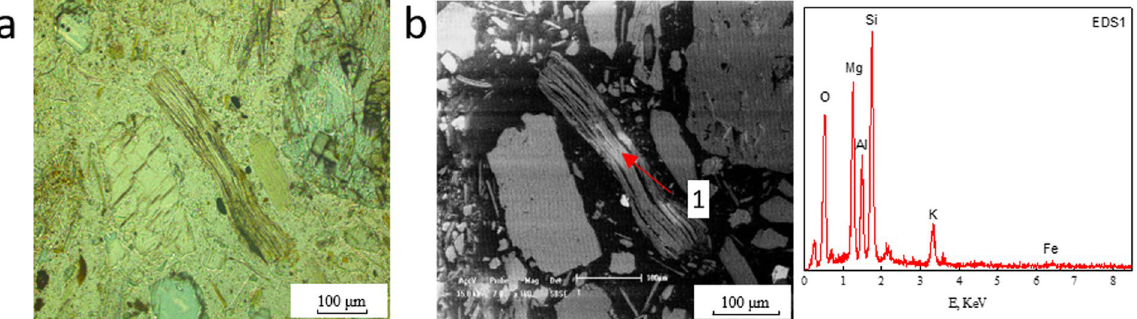
Figure 7. The morphology and elemental characteristics of biotite after leaching at 80 °C. ( a ) Planar polarizing microscopy. ( b ) SEM; EDS1. The spectra corresponds to point 1 in SEM diagram.